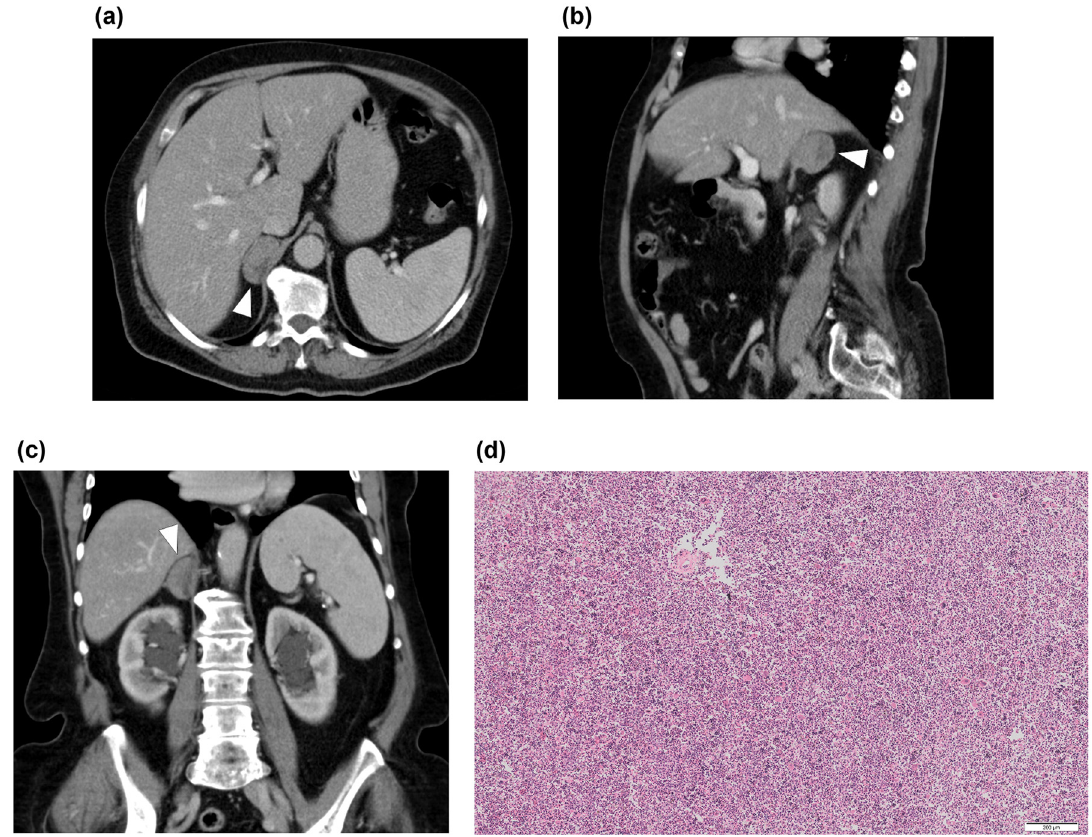
Figure 2: Abdominal CT scan revealing the mass of the right adrenal gland ( arrowheads ) in ( a ) the axial plane, ( b ) the sagittal plane, and ( c ) the coronal plane. Note the orthotopic intact spleen. There are clips after a cholecystectomy in the hepatic hilum and parapelvic cysts of the right kidney as additional fi ndings. ( d ) Histology proved heterotopic splenic tissue connected to the right adrenal gland. The sample included a large proportion of red pulp with the presence of extramedullary hematopoiesis; damaged white pulp with a central artery is also present ( hematoxylin & eosin, 100 ×)